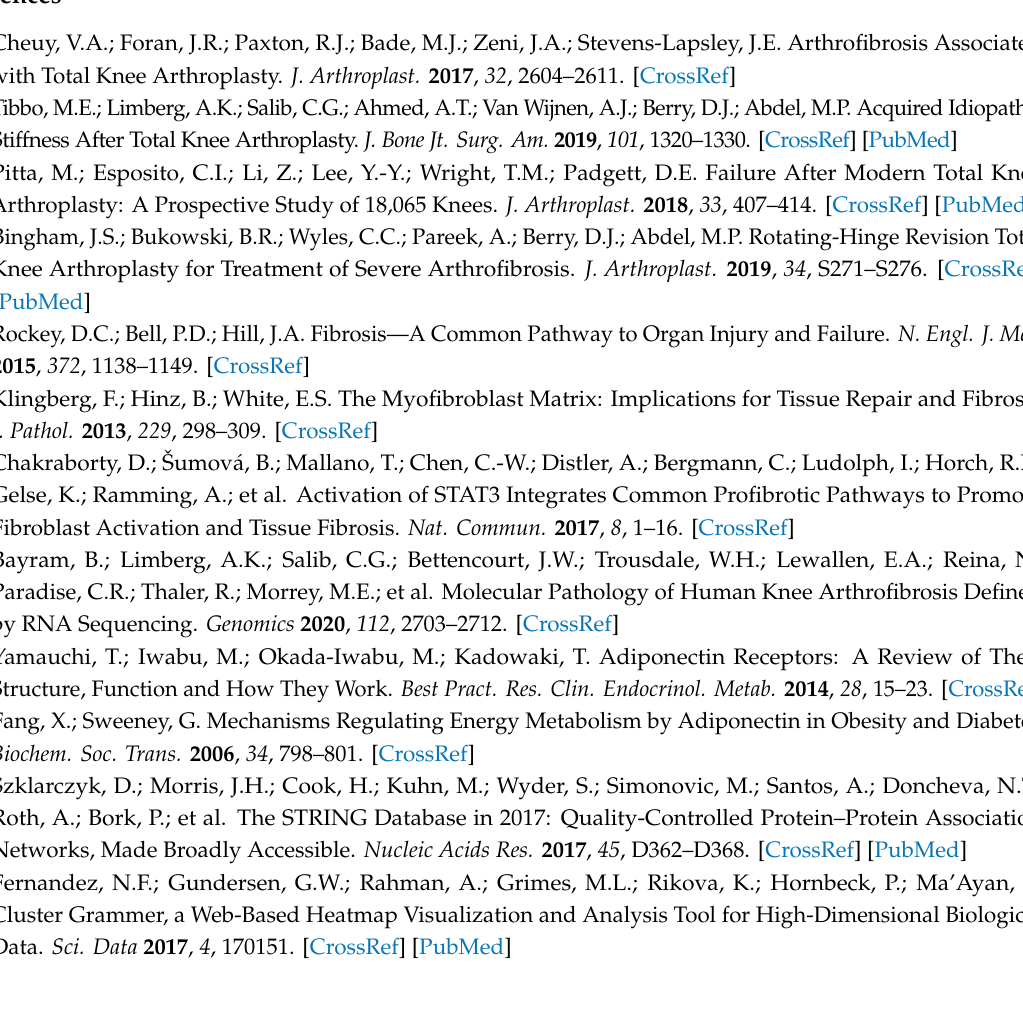
Table S1: Gene-specific primers used for analysis of gene